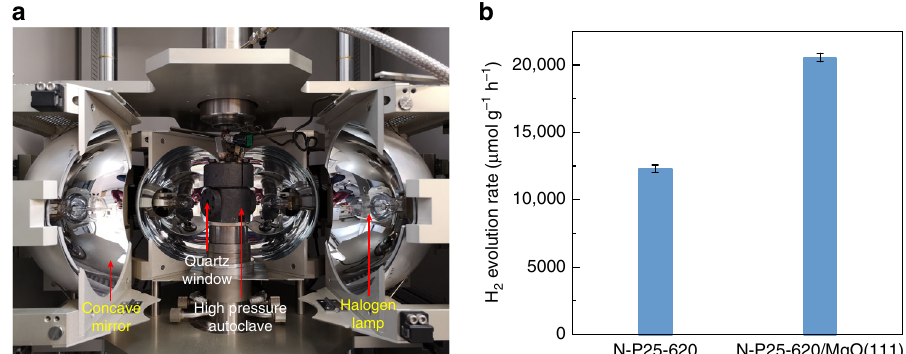
Fig. 4 The photocatalytic overall water-splitting activity tests in the light furnace. a A photographic image of a four-mirror fl oating-zone light furnace from Crystal Systems Inc. (Supplementary Fig. 18) used to mimic a solar concentrator to focus a light beam to provide both heat and photons to the N-doped TiO 2 without any other energy input from an electrical device. b The reactor temperature of 270 °C is maintained by this light source, and H 2 evolution rates of about 12 and 20 mmolg − 1 h − 1 were achieved over Au- promoted N-P25-620 and N-P25-620/MgO(111), respectively. Error bars indicate the standard